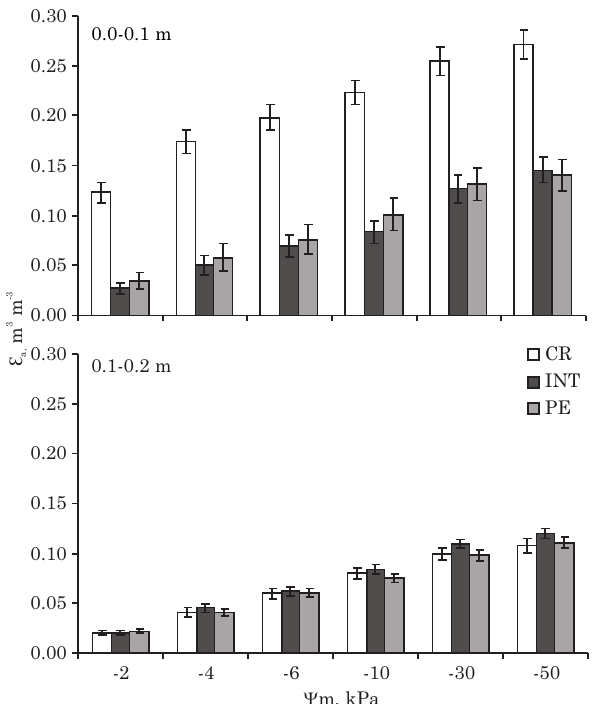
Figure 2. Mean values of air-filled porosity ( Ɛ a ) at the sampling locations crop row (CR), interrow (INT) and the point equidistant between CR and INT (PE) in two soil layers (0.0-0.1 and 0.1-0.2 m). Overlapping confidence intervals of the mean indicate no statistical difference